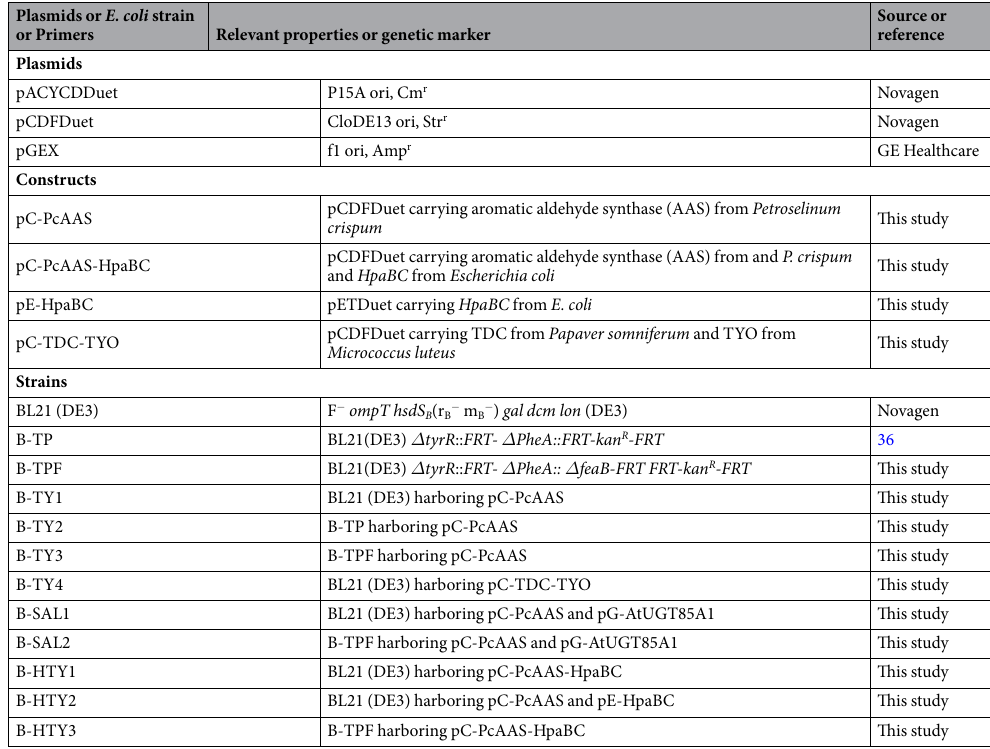
Table 1. Plasmids, Escherichia coli strains, and primers used in this